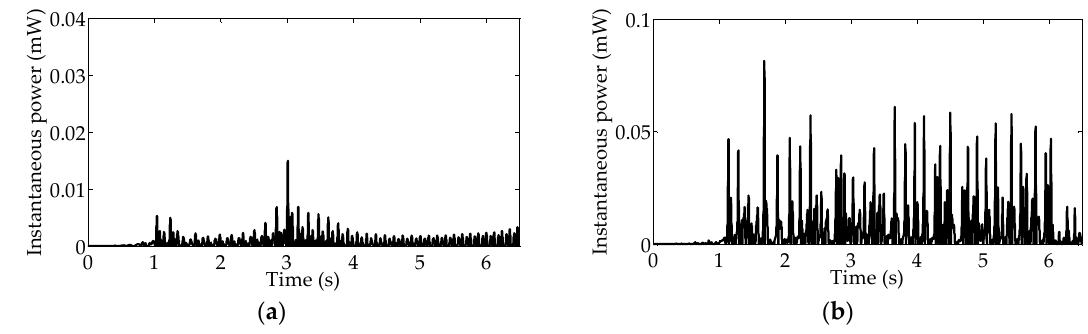
Figure 16. Harvested powers: ( a ) under up-sweep excitation; ( b ) under the combination of up-sweep excitation and on-road noise excitation.